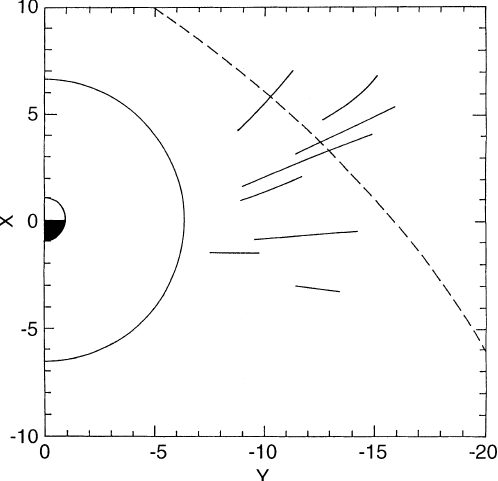
Fig. 10. Distribution in the GSM equatorial plane of the portions of the INTERBALL orbit where LLBL was encountered from the end of August to the end of September 1995. The orbital period is approximately 4 days, so that the satellite orbit has drifted by about 4 (cid:176) between two consecutive inbound passes in the dawn sector. A geostationnary orbit and a simple model magnetopause are shown